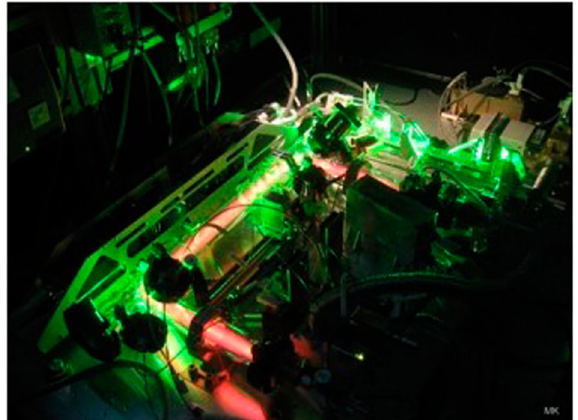
Fig. 3 The plasma chamber of the PK-4 experiment. The orange plasma glow in the glass tube of the plasma chamber and the green re fl ections of the illumination laser are